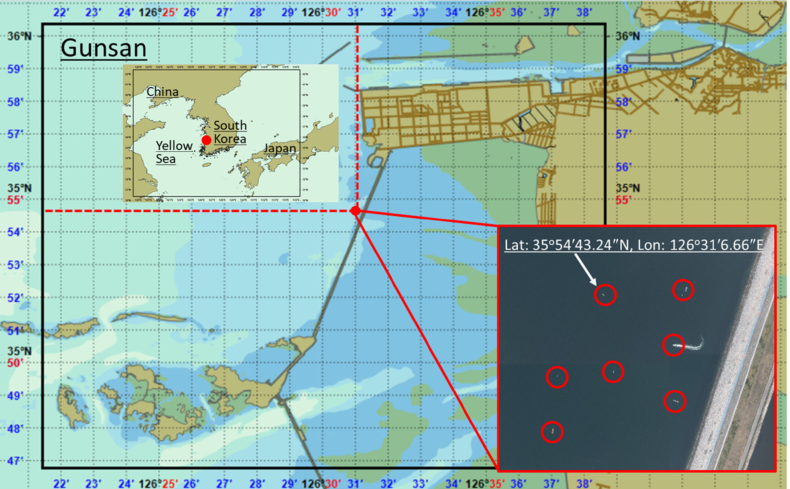
Figure 3. Location of the offshore field experiment for hyperspectral image acquisition using the airborne system equipped with high-resolution optical and hyperspectral cameras. Aerial images were taken at an altitude of 1 km in the waters near the Saemangeum Embankment in Gunsan City, South Korea.